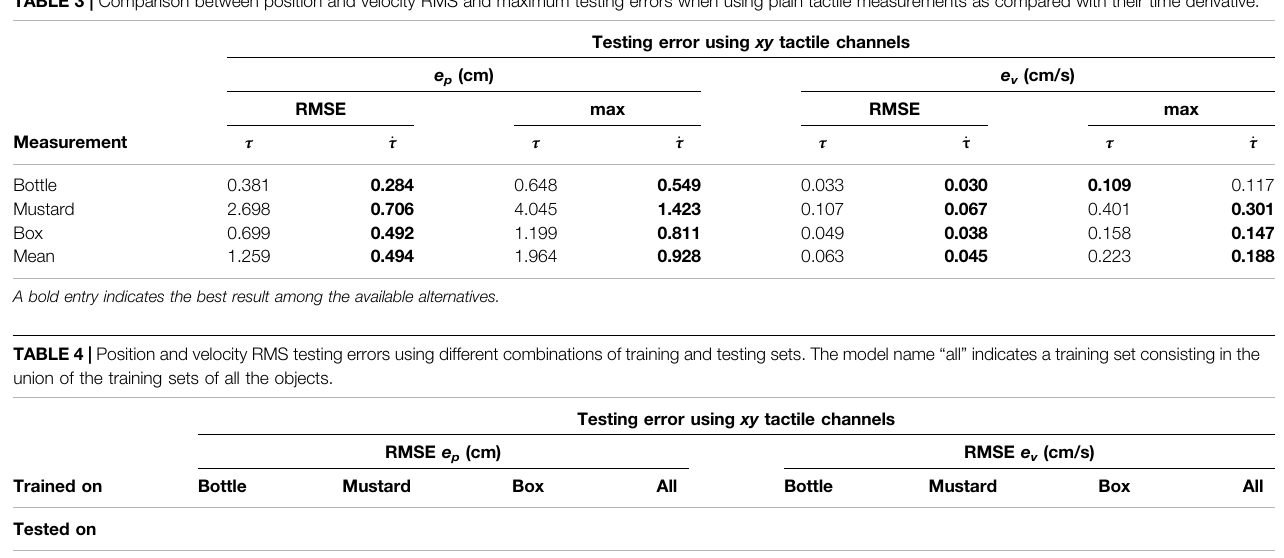
TABLE 3 | Comparison between position and velocity RMS and maximum testing errors when using plain tactile measurements as compared with their time derivative.